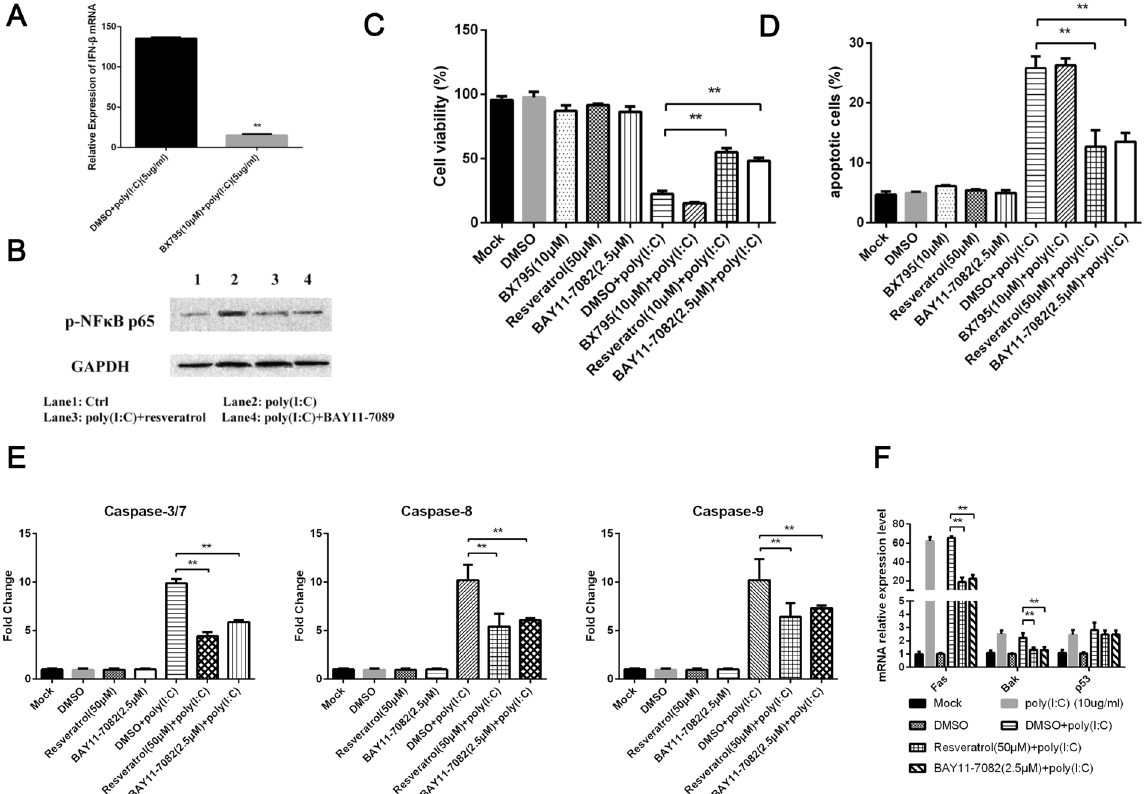
Figure 5. Poly(I:C)-induced apoptosis mediated by NF- κ B activation, independently of type I IFN signaling. ( A ) Verification of IRF3 inhibitor effect in avian cells. ( B ) Verification of NF- κ B inhibitor effect in avian cells. ( C ) MDCC-MSB1 cells were pre-treated with the BX795, resveratrol, BAY11-7089, or DMSO (used as control) before culture with or without poly (I:C) (10 μ g/ml) for 24 hours. The percentage of cell viability is shown. ( D ) The percentage of apoptotic cells in MDCC-MSB1 cells, treated as described in C, was shown. ( E ) The caspase activity of MDCC-MSB1 cells, obtained as described in D, was measured. ( F ) Transcriptional kinetic of pro- apoptotic factors in MDCC-MSB1 cells, treated as described in C, was shown. The asterisk ( * ) or double asterisk ( ** ) respectively indicates p < 0.05 or p < 0.01 in statistical difference from controls. The bars represent an average of multiple